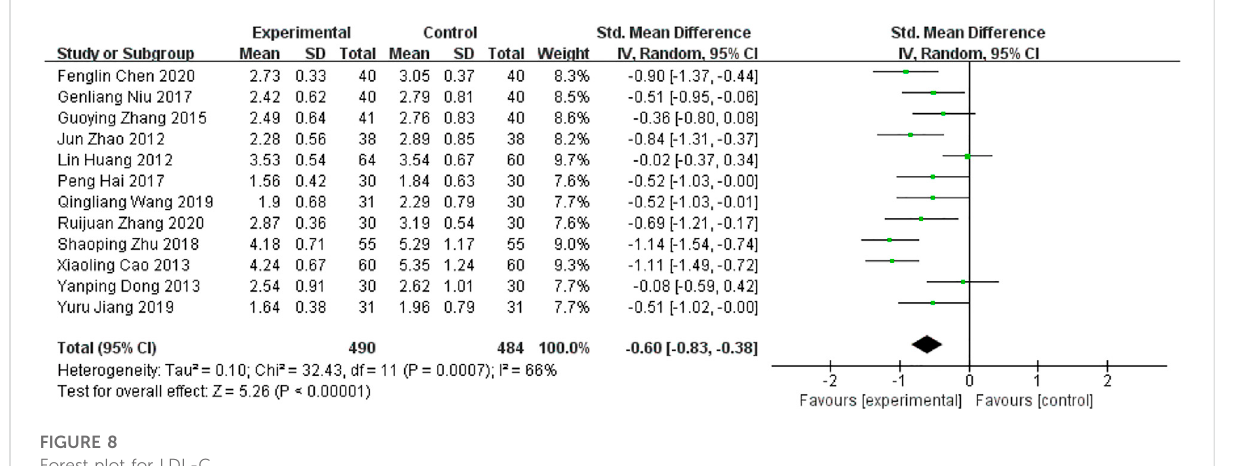
FIGURE 8 Forest plot for LDL-C.